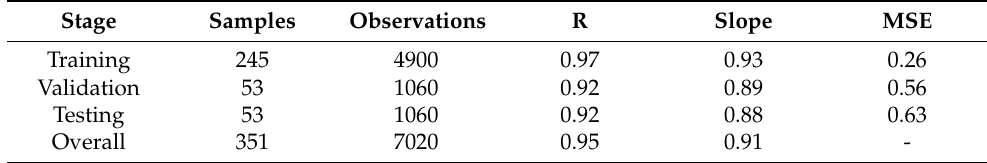
Table 5. Regression machine learning model results in predicting wine sensory descriptors using NIR error.